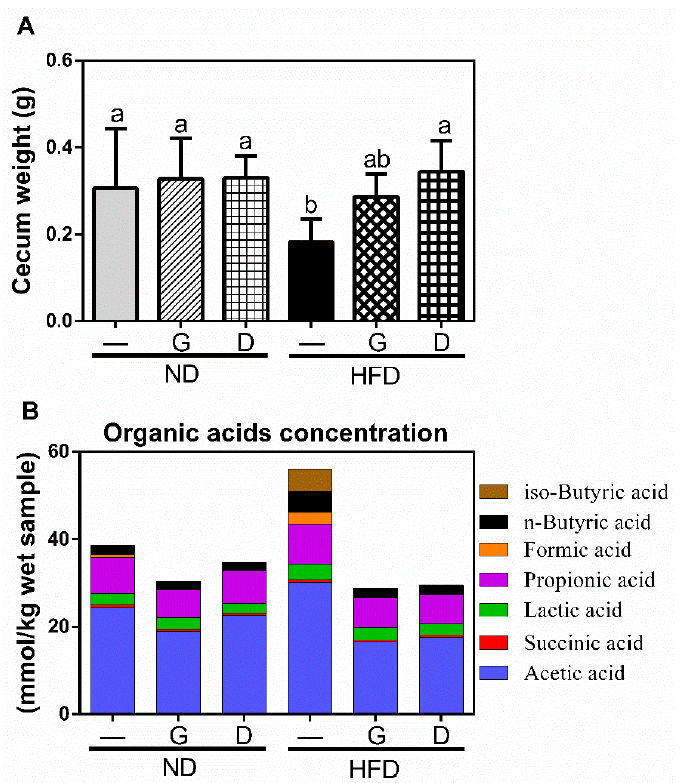
Figure 6. The effects of garlic supplementation on cecum weight ( A ). The cecum weight including cecum and cecum content was measured after the mice were sacrificed. The data represent the mean ± SD of five mice for each group. Columns with different letters significantly differ ( p < 0.05). The effects of garlic supplementation on organic acid concentration in cecum content ( B ).